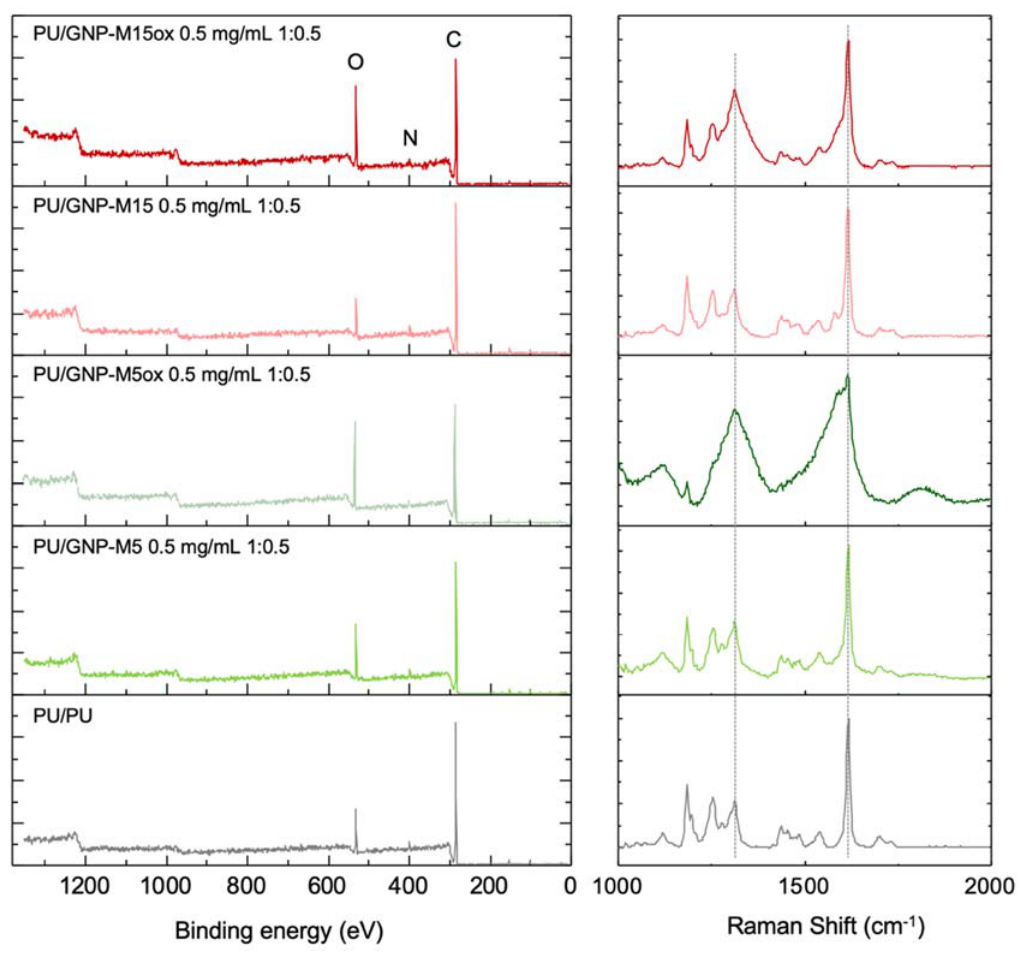
Figure 7. Characterization of surface chemistry of PU / PU and PU / GNP coatings with intermediate GNP concentration (0.5 mg / mL) and intermediate GNP:PU ratio (1:0.5): XPS survey spectra and C / O ratios (left panel) and Raman spectra (right panel).